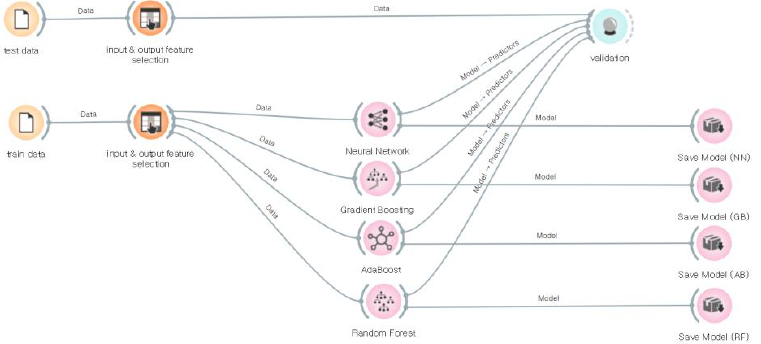
Figure 7. Model developed using Orange software [79].